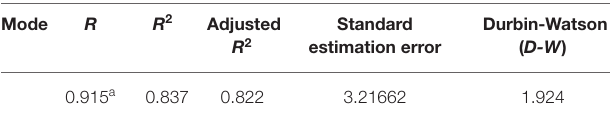
TABLE 4 | Summary of regression models for predicting the risk of depression in patients with short-term insomnia. Mode